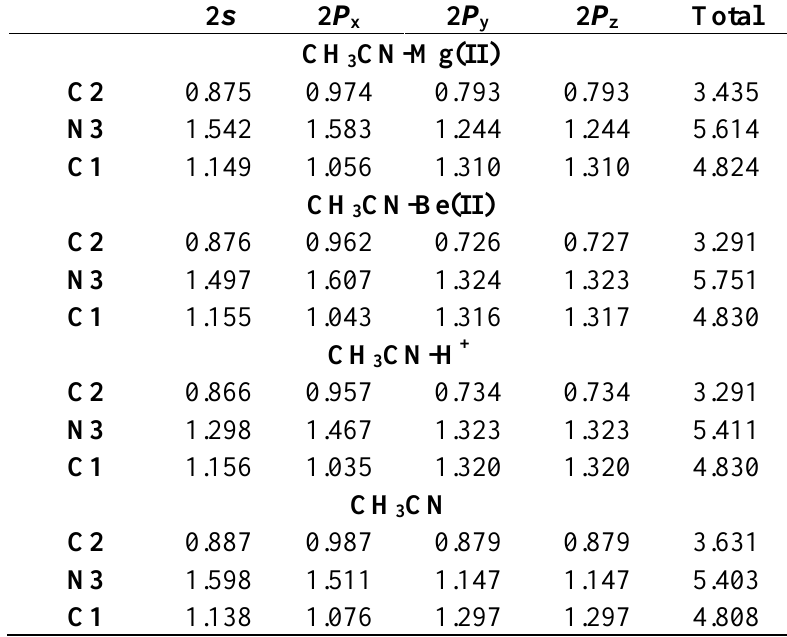
Table 8. † Orbital occupancies of acetonitrile and its complexes with Be(II), Mg(II) and H +